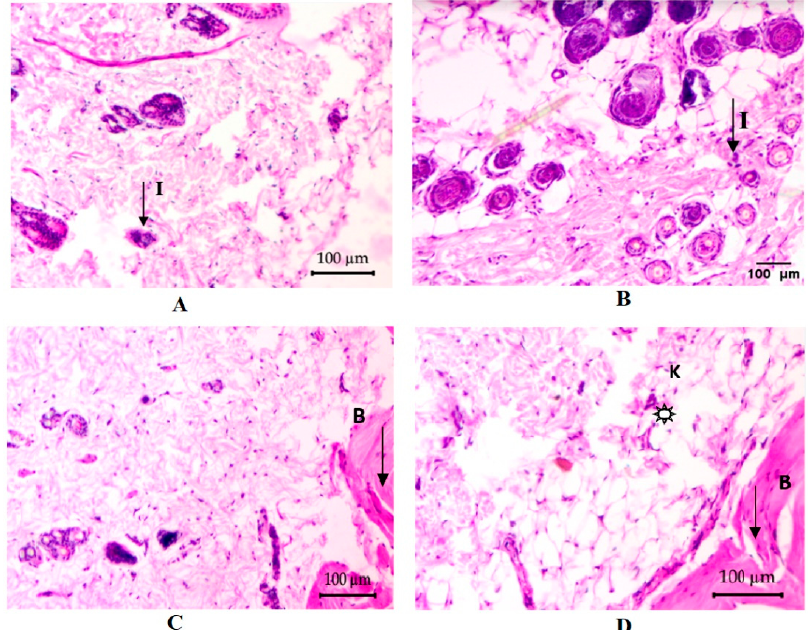
Figure 12. Representative photographic images of wound areas in control, drug-free chitosan-coated NE formulation, and CNNE (1%) treated Wistar rats on days 0 and 14.